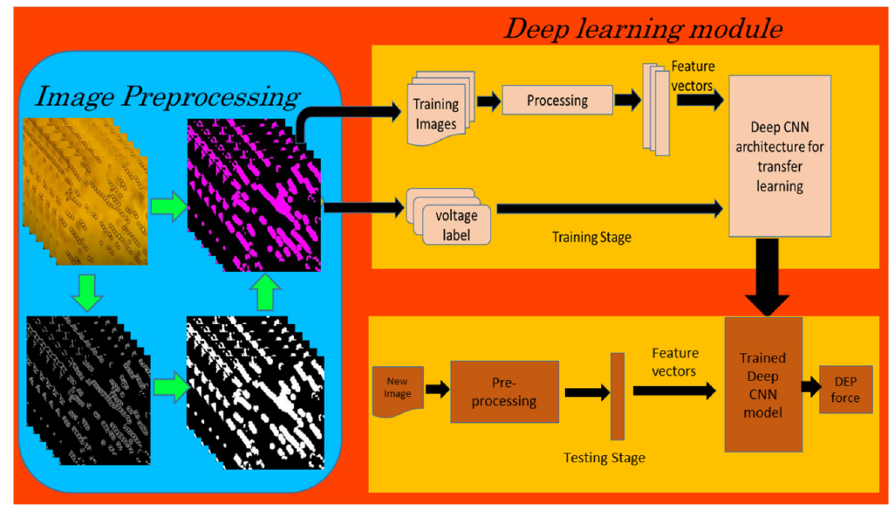
Figure 3. Block diagram of image classification using deep learning (CNN).